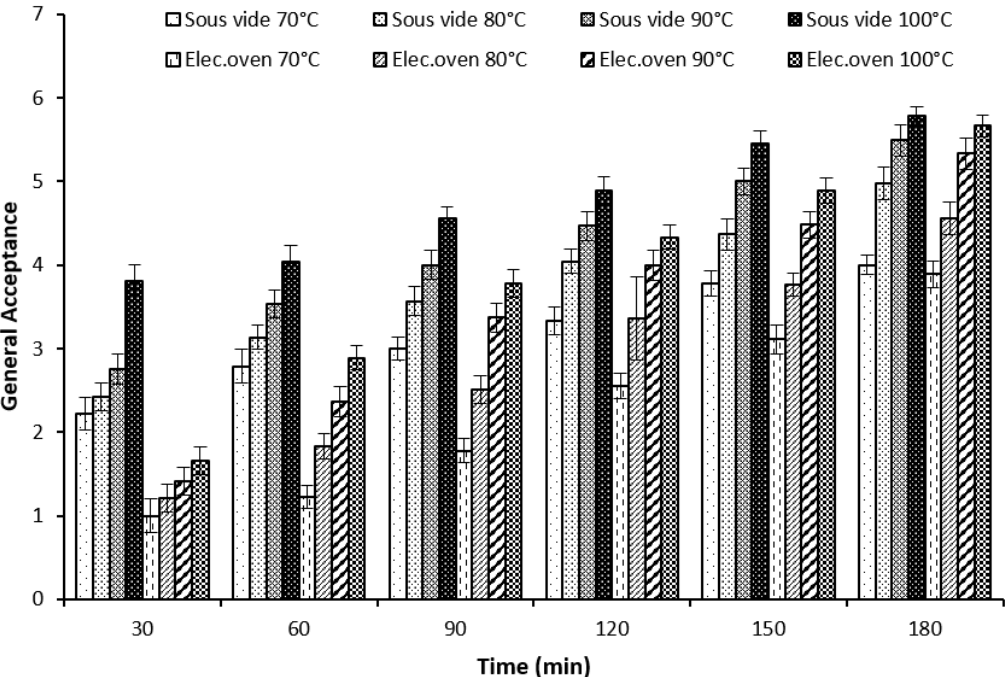
Figure 11. The effect of the cooking method (sous vide vs electrical oven) on the camel meat sensory properties (general acceptance) at different combinations of temperature and